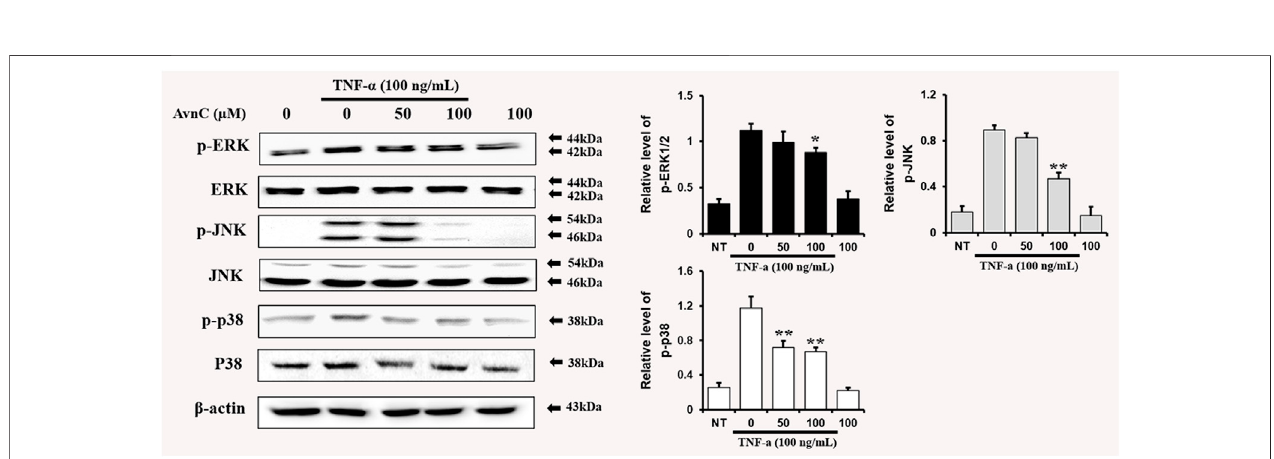
FIGURE 6 | Avn C inhibits MAPK phosphorylation in TNF- α -activated HASMC cells.Levels of phosphorylated ERK, p38, and JNK were assessed by Western blotting. Levels of ERK, JNK, and p38 were indicated by loaded protein as individual control. Results shown are representative of three independent experiments. Results are presented as mean ± SEM. * p < 0.05 and ** p < 0.01 indicate signi fi cant differences from TNF- α treated cells. NT, no